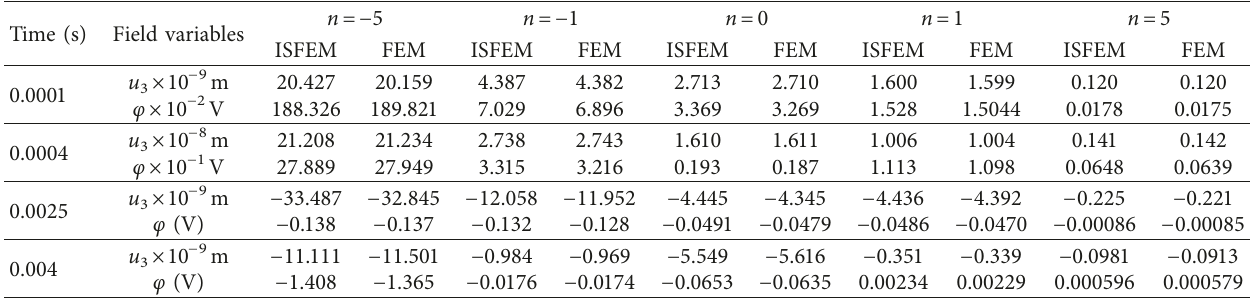
Figure 10: Cosine wave Table 4: Displacement u 3 and electrical potential φ at the loading point with the gradient parameter n beam based on PZT-4 under cosine load.